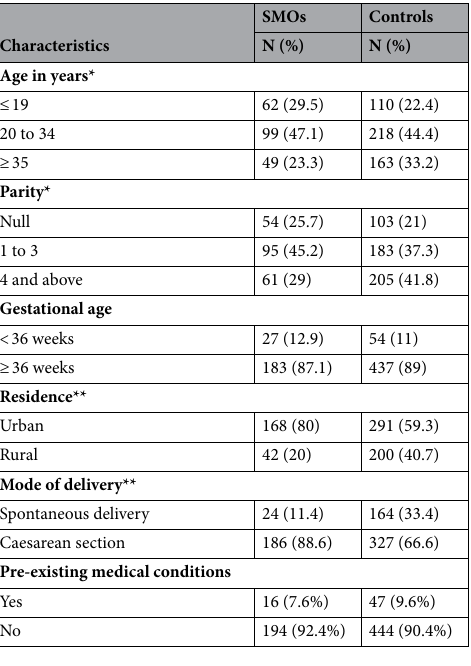
Table 1. Demographic, obstetric and medical characteristics of women with potentially life-threatening conditions admitted to Keren Hospital. Chi-square test **significant at p = 0.001, *significant at p = 0.05. SMO severe maternal